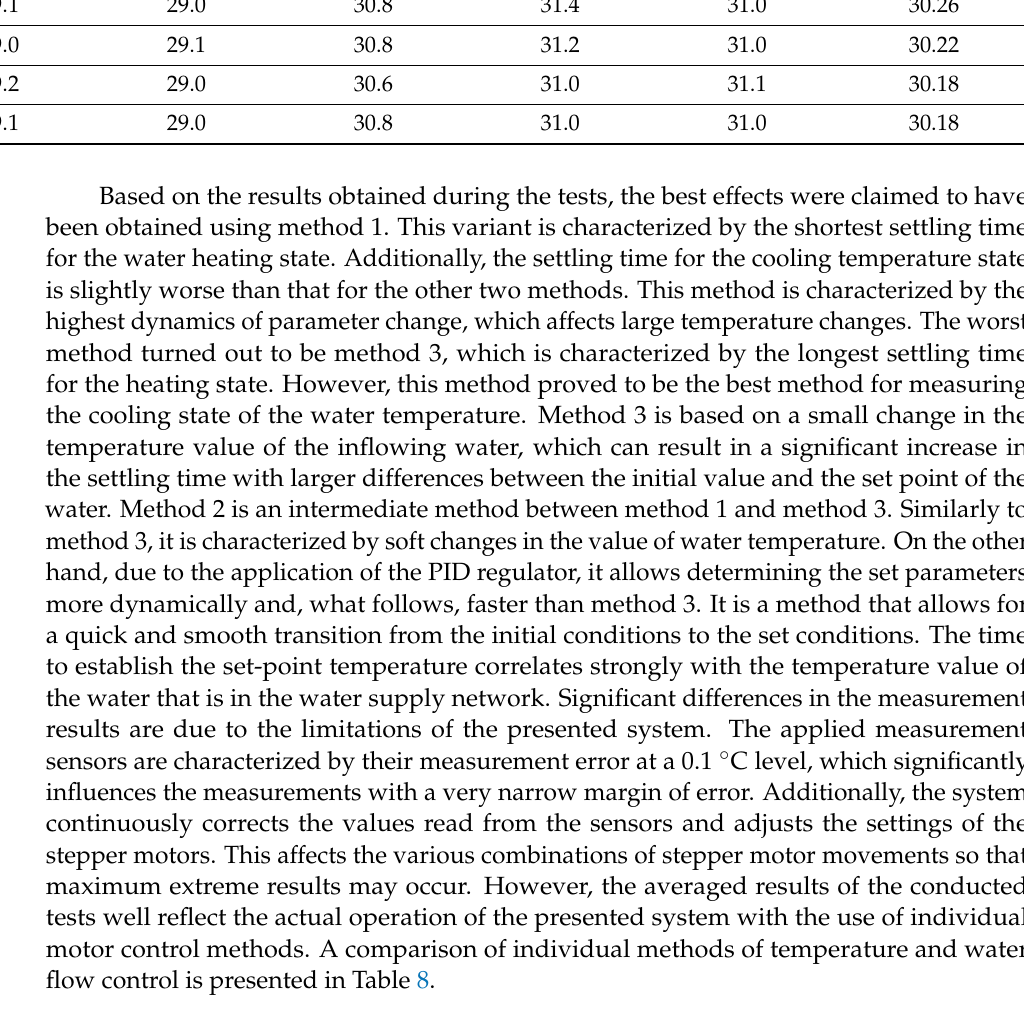
Table 8. Results of testing the stability of the